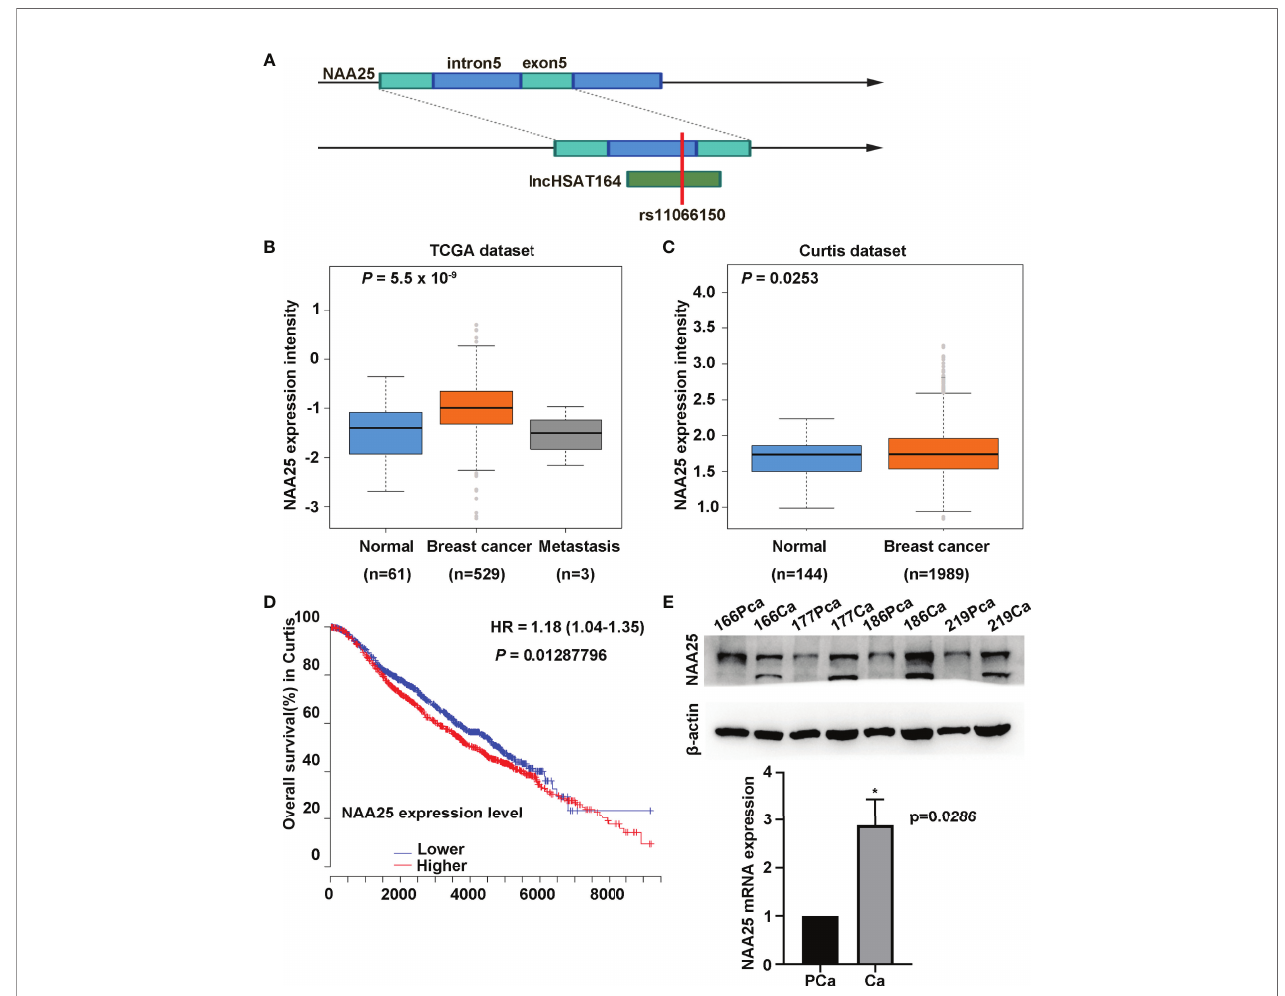
FIGURE 1 | Characterization of NAA25 gene in breast cancer. (A) rs11066150 variant schematic diagram in lncHSAT164 and NAA25. (B, C) NAA25 gene was highly expressed in breast cancer tissues compared to the controls in TCGA dataset and Curtis dataset. (D) OS analysis of patients with high and low NAA25 expression. The p value was calculated using Mann-Whitney U tests. (E) Western-blot and RT-qPCR to analyze NAA25 expression in breast cancer tissues and para-carcinoma tissues, NAA25 was highly expressed in breast cancer tissues. The two bands are all NAA25 . * p <